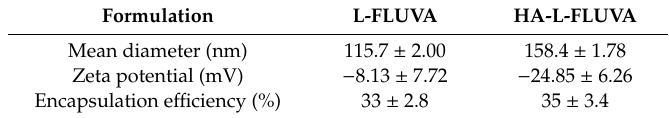
Table 1. Mean diameter, zeta potential, and encapsulation e ffi ciency of